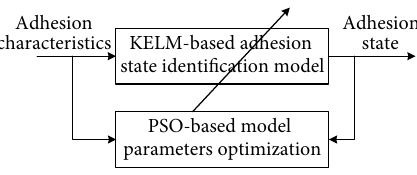
Figure 3: Framework of establishing wheel/rail adhesion state identification model based on KELM and